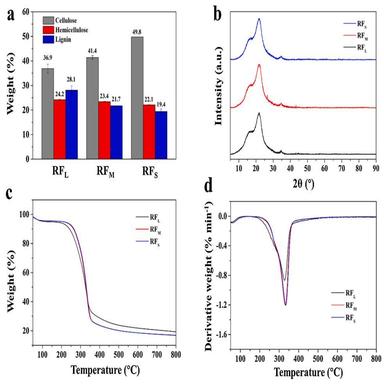
(a) The composition of cellulose, hemicelluloses, and lignin in RFL, RFM and RFS, (b) XRD pattern of RFL, RFM and RFS, and TGA (c)/DTG (d) curves of RFL, RFM and RFS.